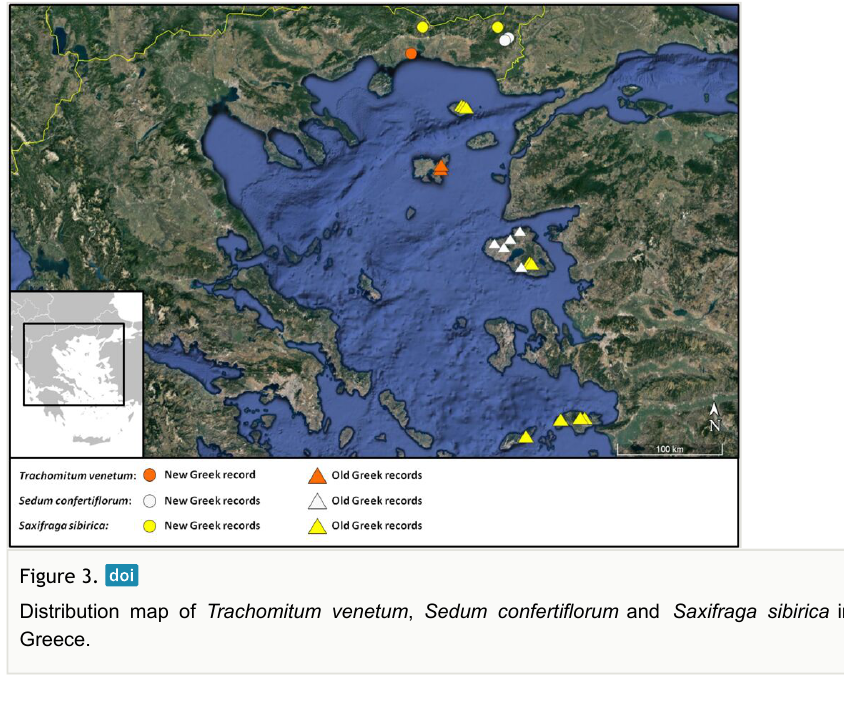
Distribution map of Trachomitum venetum , Sedum confertiflorum and Saxifraga sibirica in